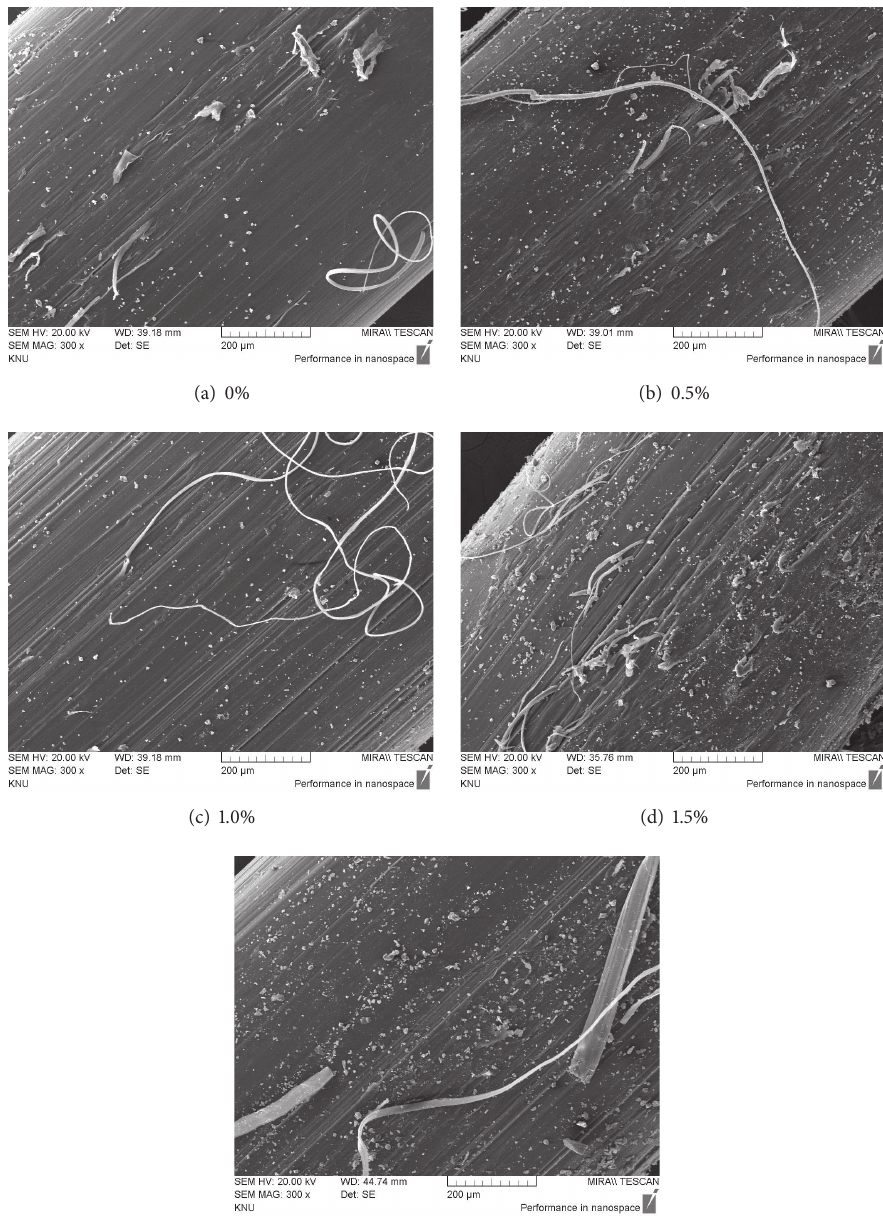
Figure 8: Microstructure of fiber surface in LMHFRCCs ( 𝑤/𝑐 = 0.4